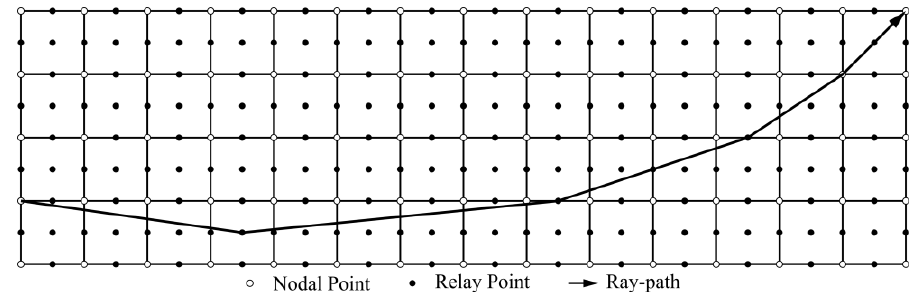
Figure 1. An approximated ray-path on a finite element mesh with relay